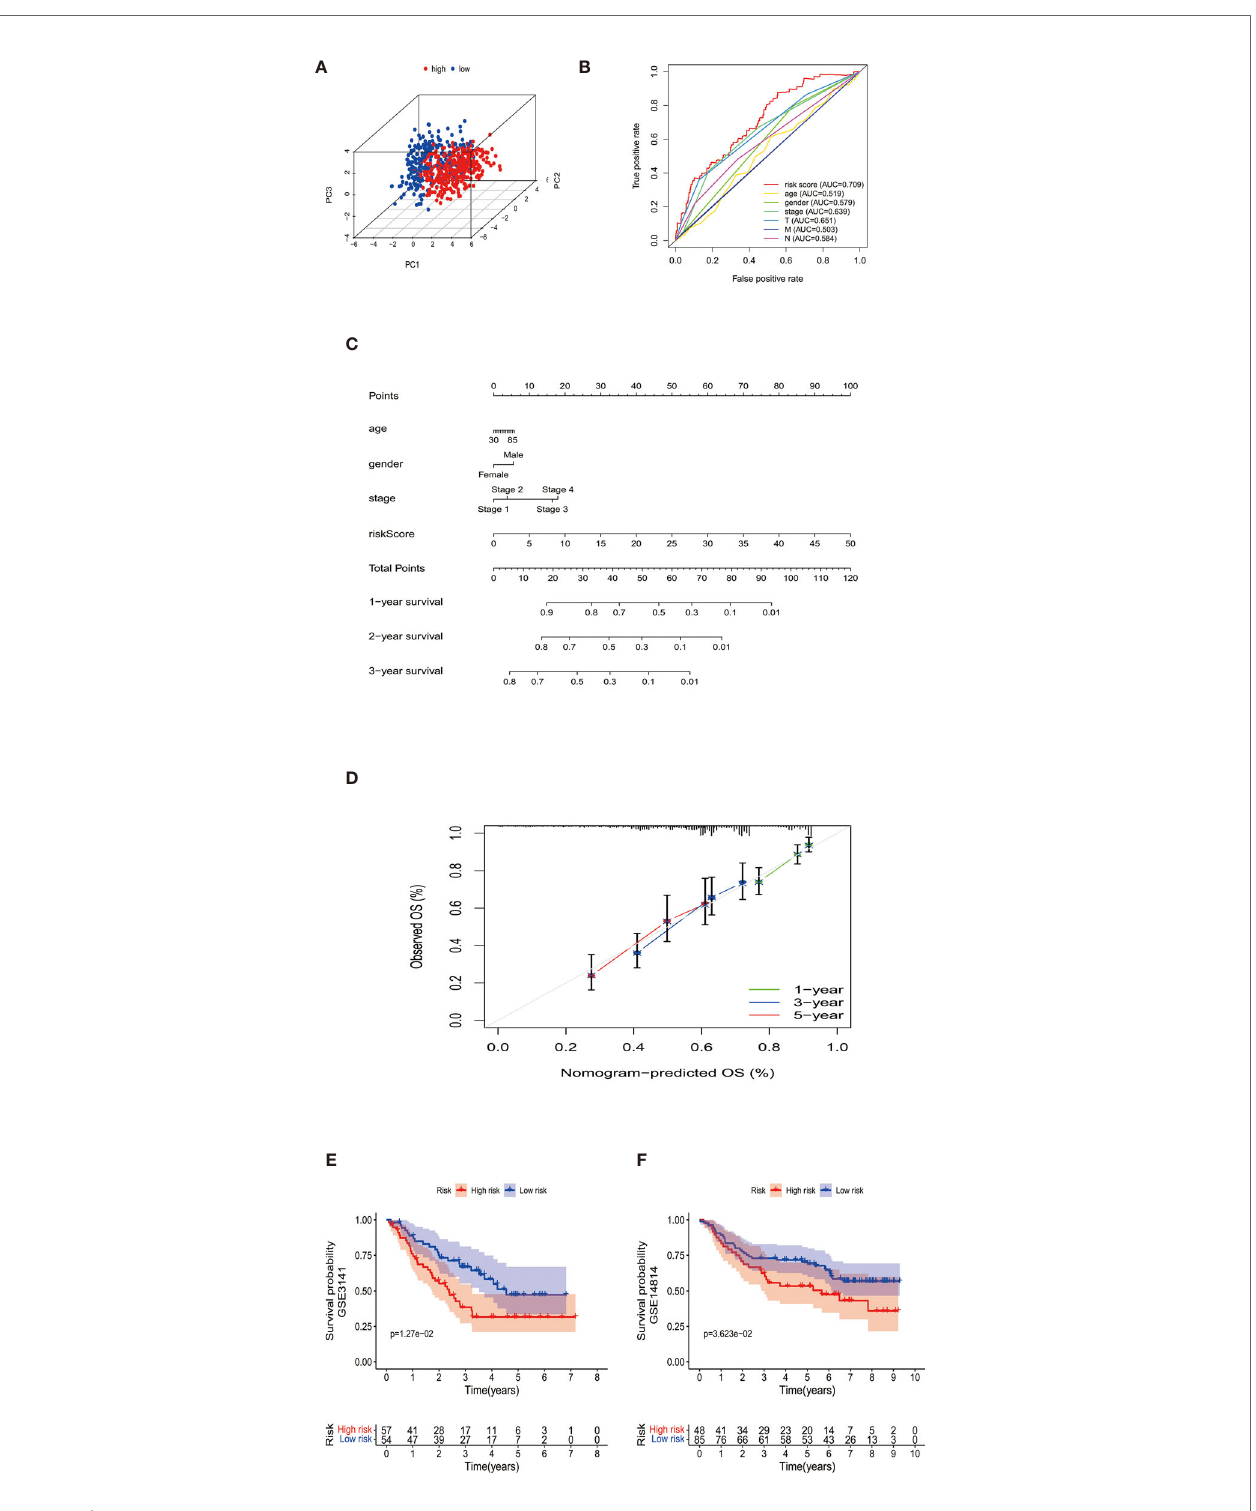
FIGURE 2 | (A) The PCA plots showed the metabolic gene signature could successfully distinguish the double-negative LUAD and LUSC patients. (B) The ROC curve analyses indicated that the AUC value (0.709) of the DEMGs signature was higher than all the other risk factors. (C) The nomogram was built to incorporate the clinical parameters and risk score to predict 1-,2-, and 3-year OS. (D) The nomogram ’ s 1-,3-, and 5-year calibrate curve revealed that the predicted OS was very close to the actual OS, indicating high accuracy. (E, F) The Kaplan-Meier plot of GSE3141 and GSE14814 showed the patients in the high-risk group had a signi fi cantly poor survival time than those in the low-risk